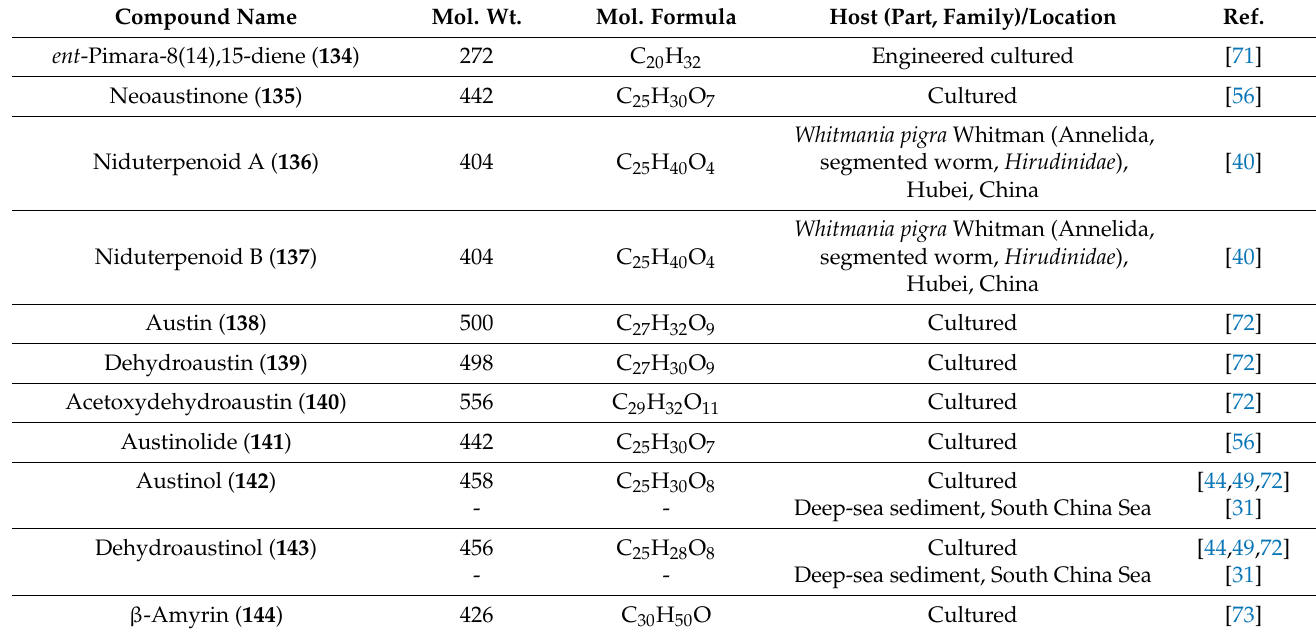
Table 10. Terpenes reported from A. nidulans